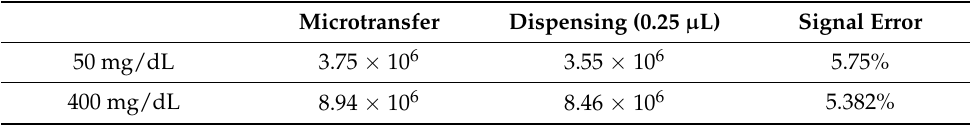
Figure 9. ( a ) Signal difference between a microtransfer and a 5 μL dispense enzyme; ( b ) signal difference between a single microtransfer and 0.25 μL dot enzyme. Table 2. Transfer and verification of error transfer.